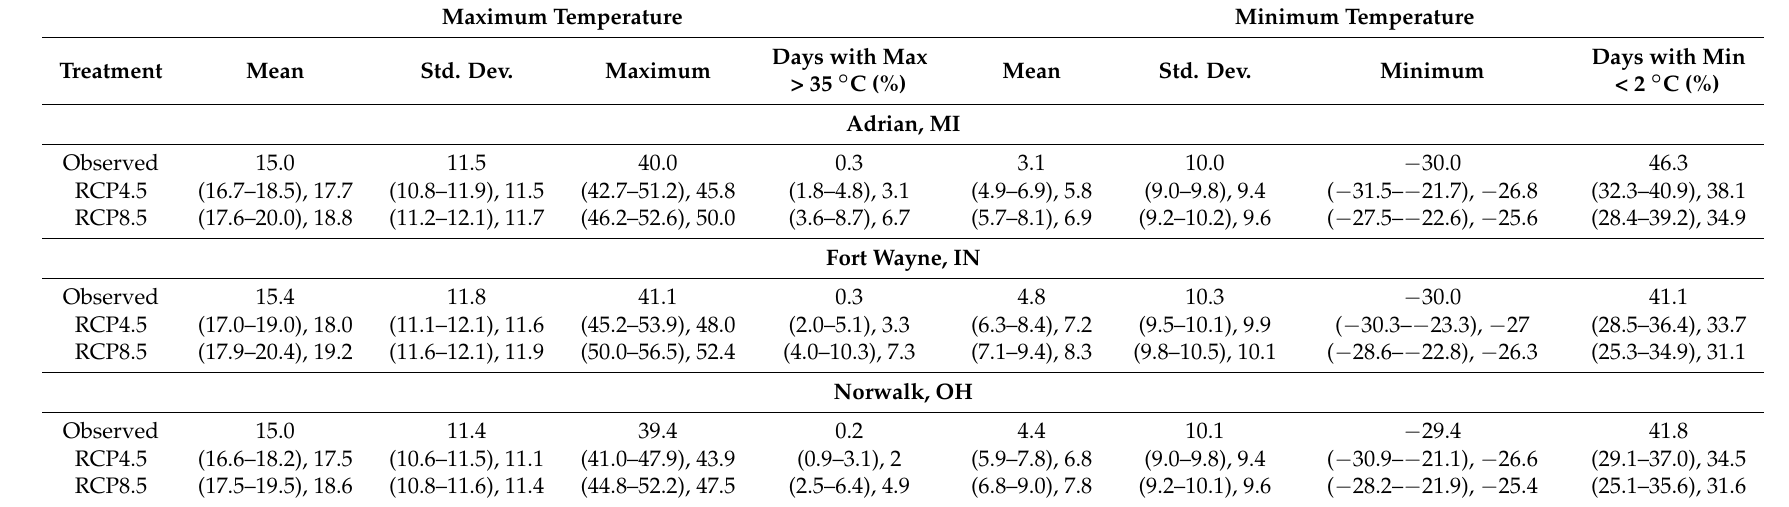
Table 7. Comparison of future climate scenarios (2006–2099) with the historical period (1966–2005) for maximum and minimum temperatures, ◦